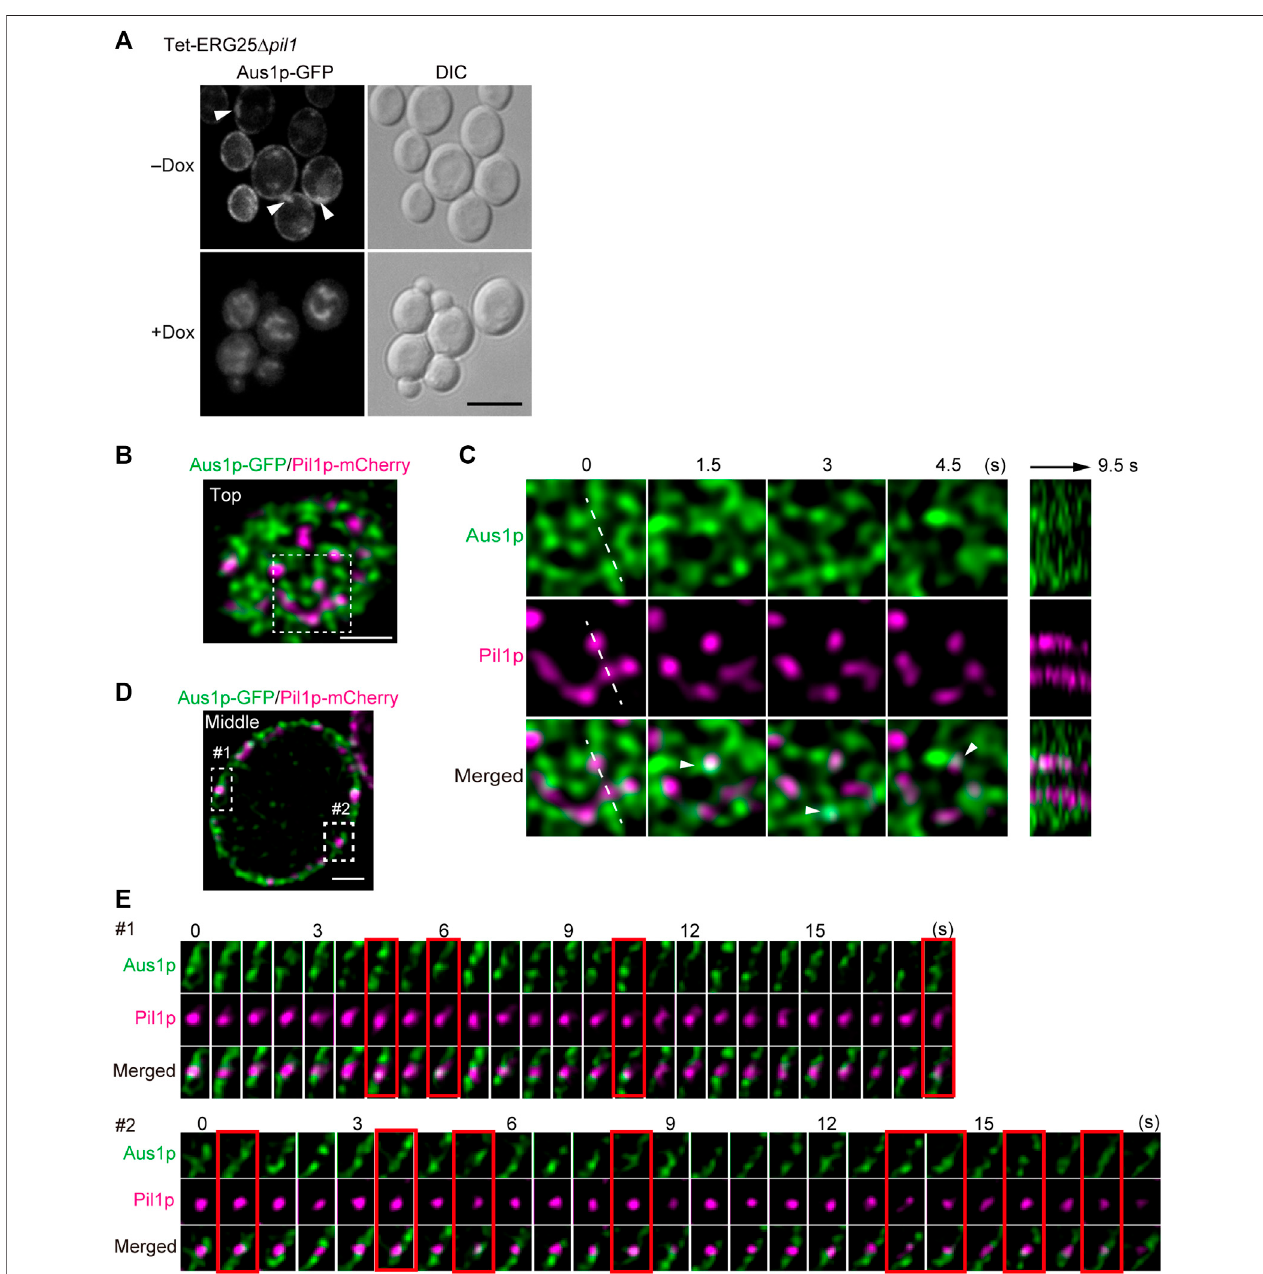
FIGURE 7 | Aus1p is compartmentalized into plasma membrane domains distinct from MCC/eisosomes. (A) Effect of PIL1 deletion on the localization of Aus1p. Tet-ERG25 pil1 Δ cells expressing Aus1p-GFP (Tet-ERG25 pil1 Δ _Aus1G) were grown to exponential phase at 30 ° C in minimal medium containing bovine serum and observed using fl uorescence microscopy after incubation with or without Dox for 3.5 h. Scale bar represents 5 µm. (B) Distribution of Aus1p and Pil1p on the plasma membrane. Wild-type cells co-expressing Aus1p-GFP and Pil1p-mCherry (WT_Aus1G/Pil1R) were incubated in the presence of serum and observed at the cell surface (Top) by high-resolution confocal microscopy. (C) Time-lapse imaging of the boxed region of (A) . Right panel shows the kymograph obtained by recording acrossthe dashed line ofthe middle panels ina time-lapse image taken every 0.5 s. Co-localization ofAus1 and Pil1p appearsin white, asindicated byarrowheads. (D) DistributionofAus1pandPil1pontheplasmamembraneinthetraverseregion. (E) Time-lapseimagingoftheboxedregionof (D) .Imagesweretakenat0.75-sintervals. The images surrounded with red lines represent the co-localization of Aus1p-GFP and Pil1p-mCherry. All scale bars represent 2 µm.